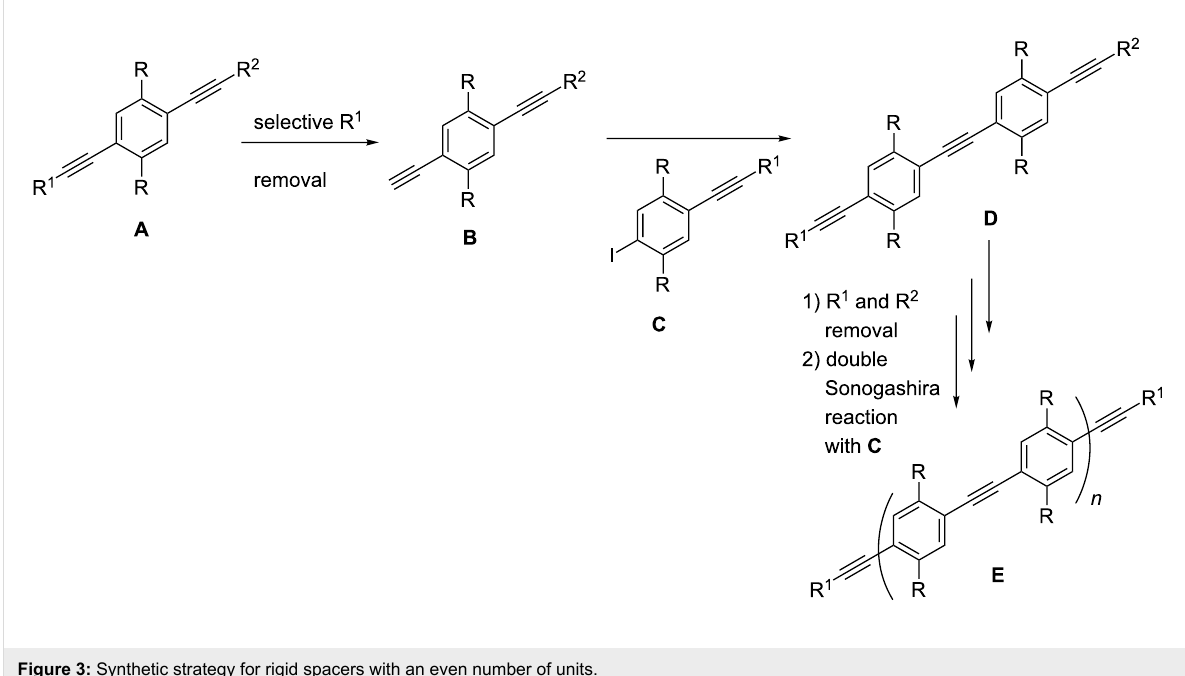
Figure 3: Synthetic strategy for rigid spacers with an even number of units.